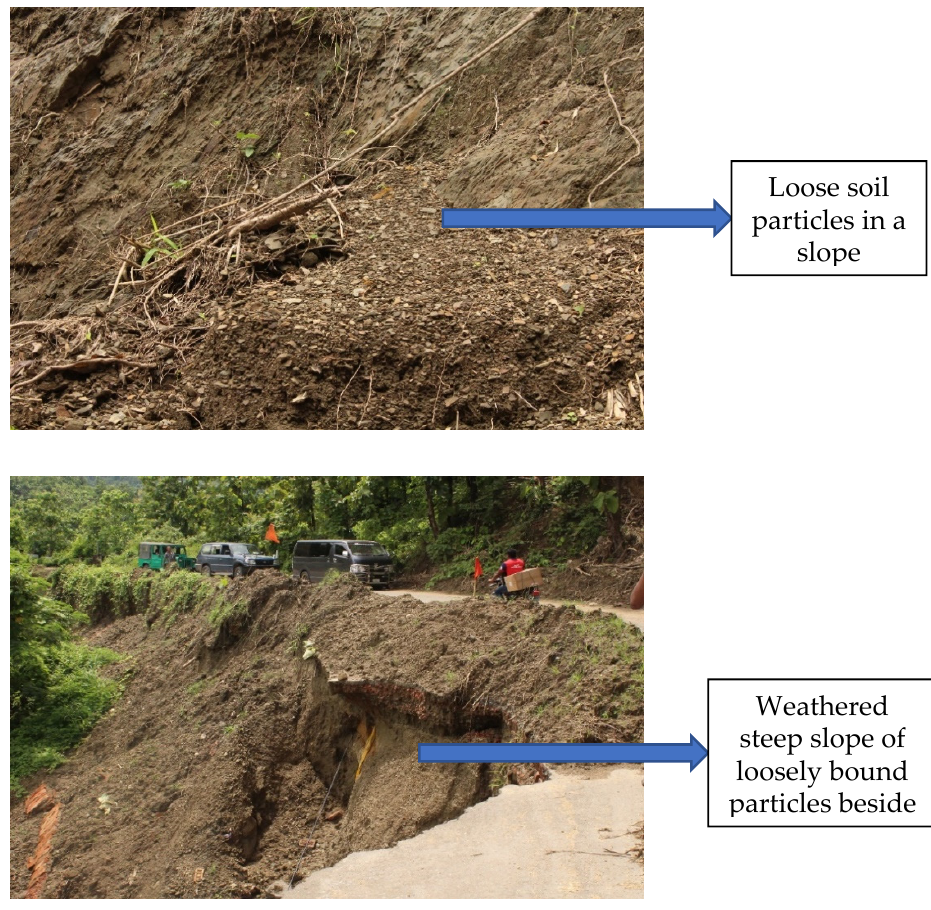
Figure 6. Loose soil particles in a sloped surface ( top ) and a weathered steep slope composed of loose, layered soil strata beside a narrow road ( bottom ).